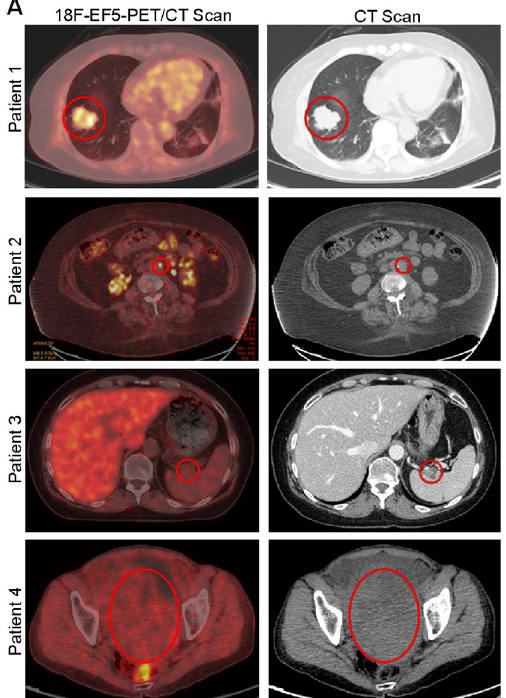
Figure 1. [ 18 F]EF5-PET/CT positivity in tumors from CCOC patients. Representative images from each of the four CCOC patients. In two cases, patient 1 and patient 2, detectable EF5 positive was